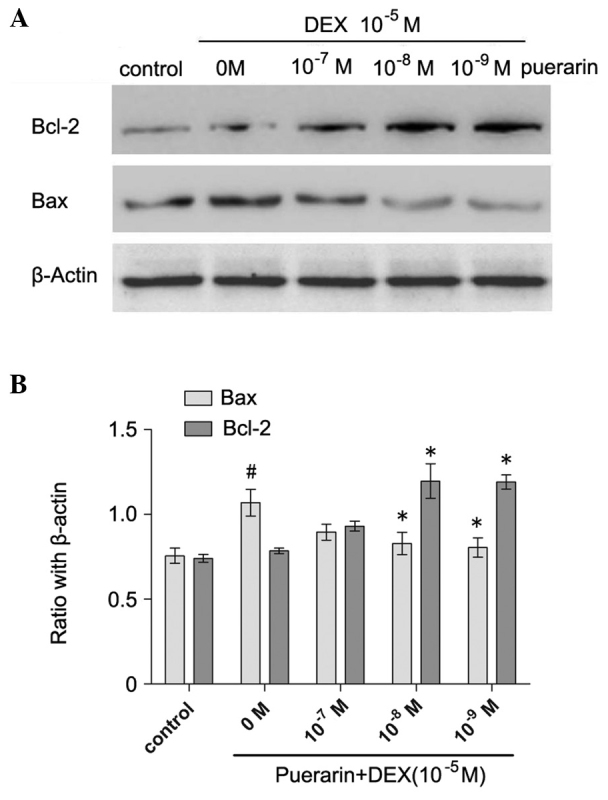
Effects of puerarin on DEX-induced changes in of Bcl-2 and Bax. (A) Cells were treated with puerarin (0, 10−7, 10−8 and 10−9 M) for 3 h prior to incubation with DEX (10−5 M) for 48 h. Western blot analyses for Bcl-2, Bax and β-actin was performed. (B) Relative expression levels of Bcl-2 and Bax compared with β-actin. Data are presented as the mean ± standard deviation (n=3). *P<0.05, vs. DEX; #P<0.05, vs. control. DEX, dexamethasone; Bcl-2, B-cell lymphoma-2; Bax, B-cell-associated X protein.